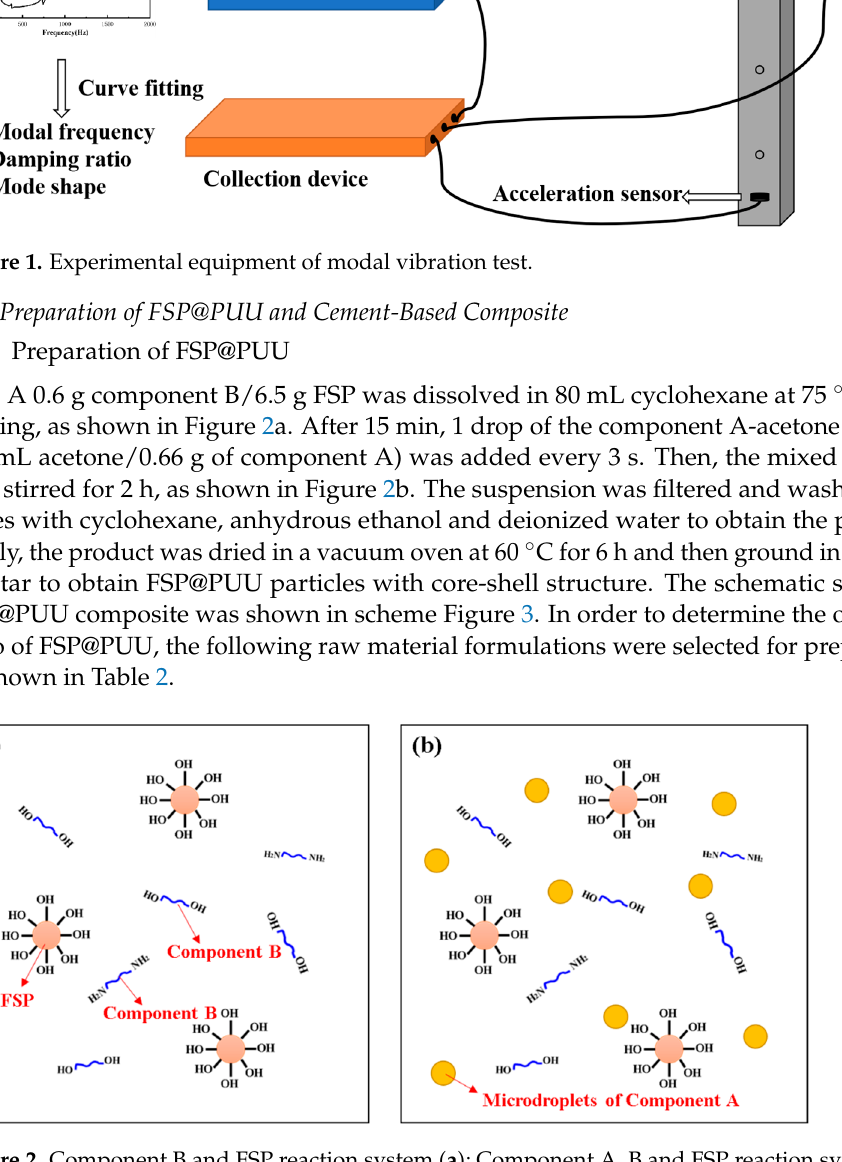
Figure 3. Schematic diagram of the preparation of FSP@PUU. Table 2. The raw material formulations for the preparation of FSP@PUU. Sample